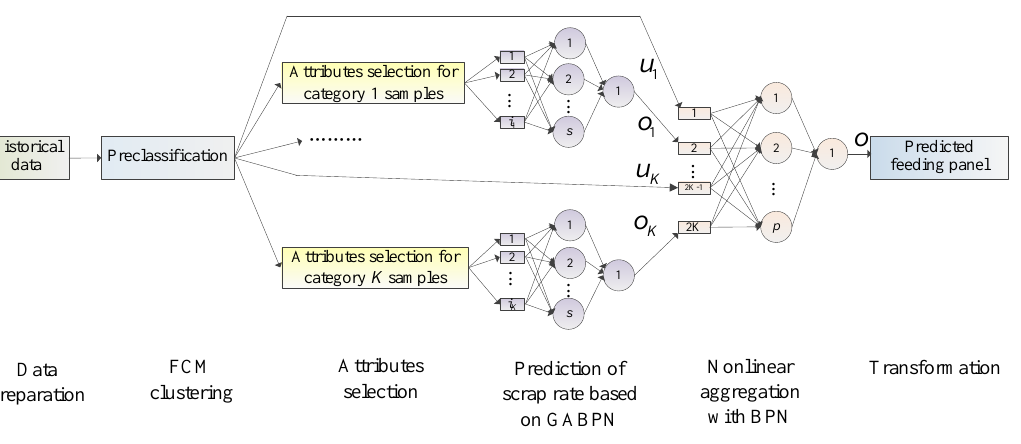
Figure 1. The architecture of the proposed fuzzy c-means–genetic algorithm with back-propagation networks (FCM–GABPN).